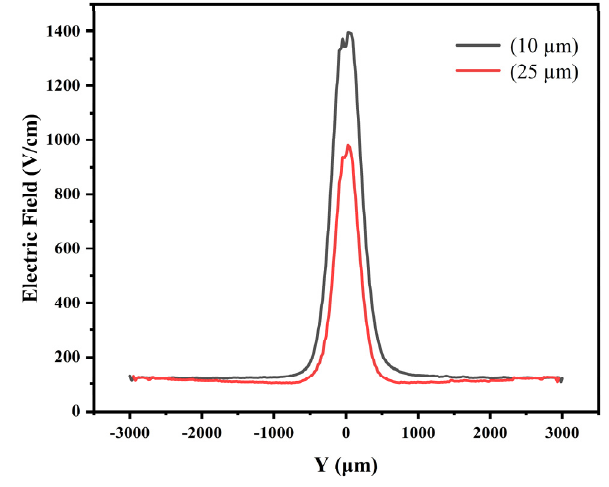
Figure 8. Distribution of electric field in the 1D cross section in SDD (at Z = 210 µ m).